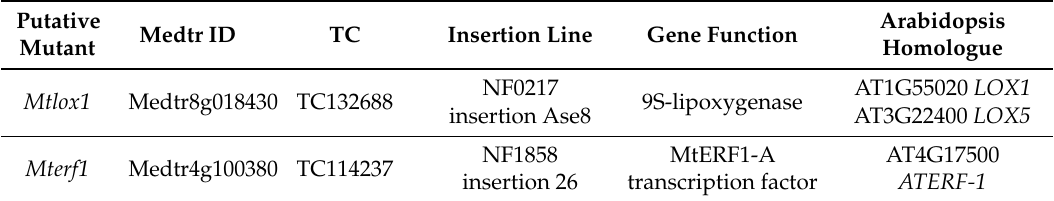
Table 2. Details of Tnt1 -insertion lines used in this study.